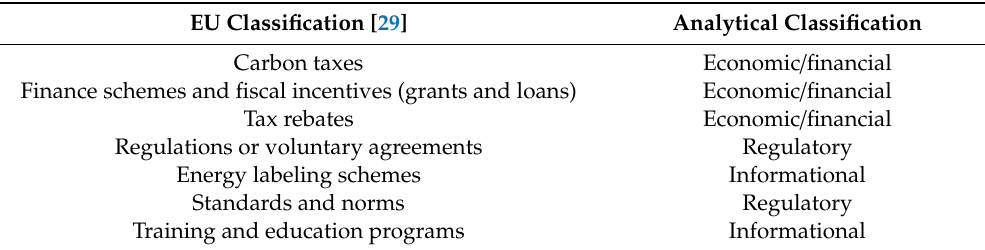
Table 1. Categorization of building energy policy